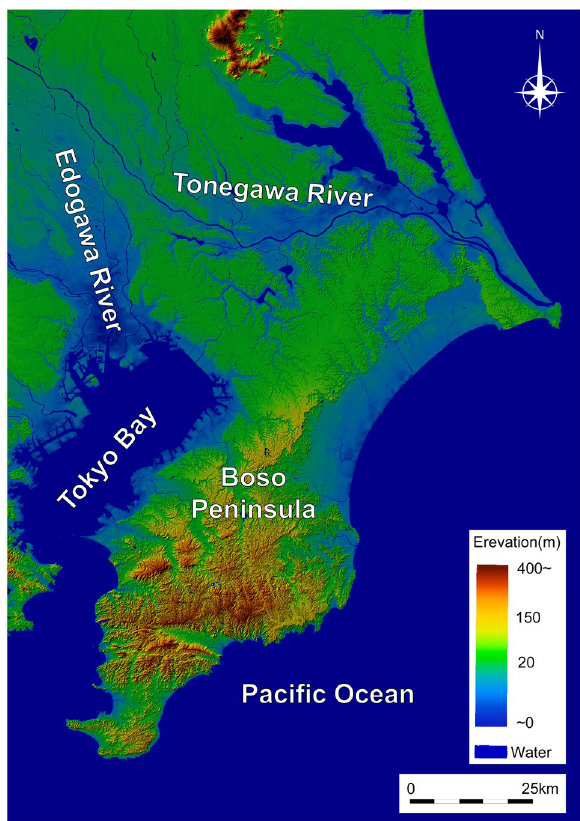
Figure 1. Around the study area. Partially modified based on the map of Geospatial Information Authority of Japan. The maps were created by using Microsoft Power Point office 365 based on the Digital Map published by Geospatial Information Authority of Japan website (https:// maps. gsi. go. jp/) 25 .